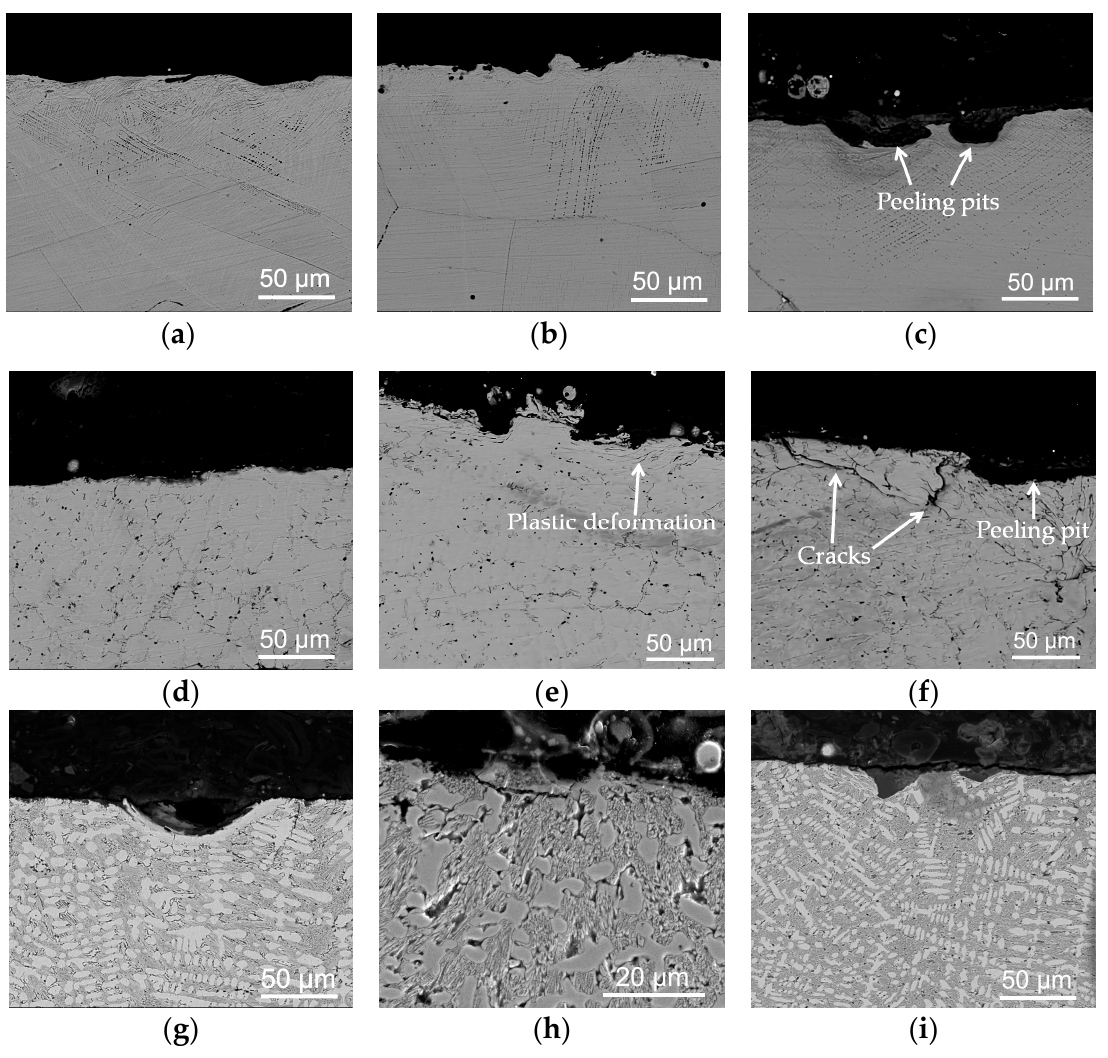
Figure 10. Morphologies of the cross-section of the worn specimens: ( a – c ) The Hadfield steel: the glass sand, the granite, and the quartz sand, respectively; ( d – f ) The over-lapped cladding layer: the glass sand, the granite, and the quartz sand, respectively; ( g – i ) The dot-shaped cladding layer: the glass sand, the granite, and the quartz sand, respectively.